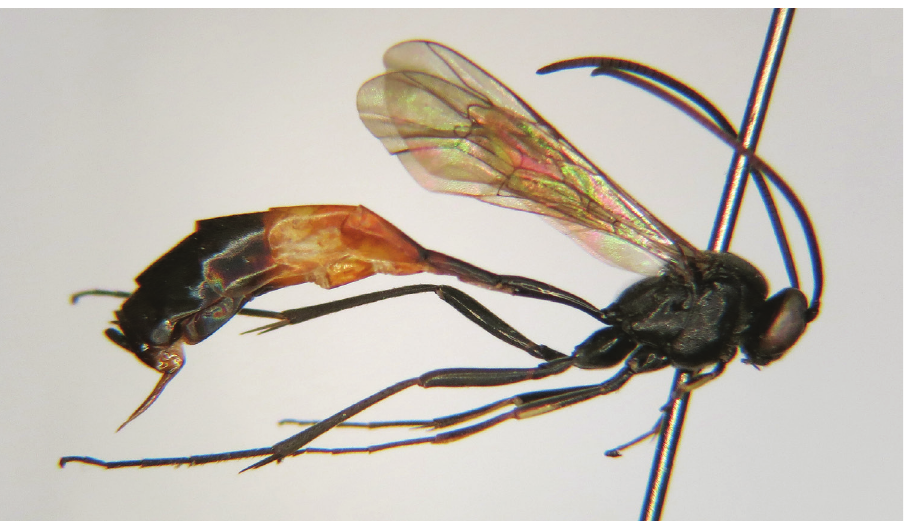
Figure 2. Heinrichiella obscura comb. n., female habitus